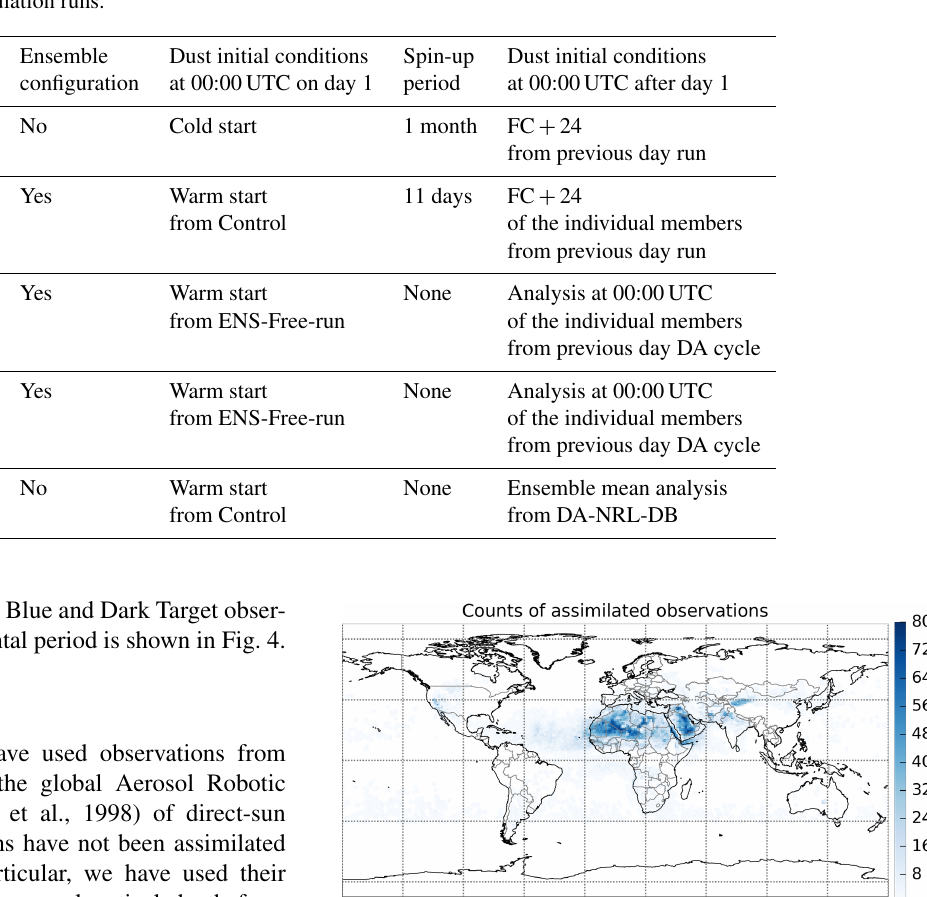
Table 1. Characteristics of the simulation runs.